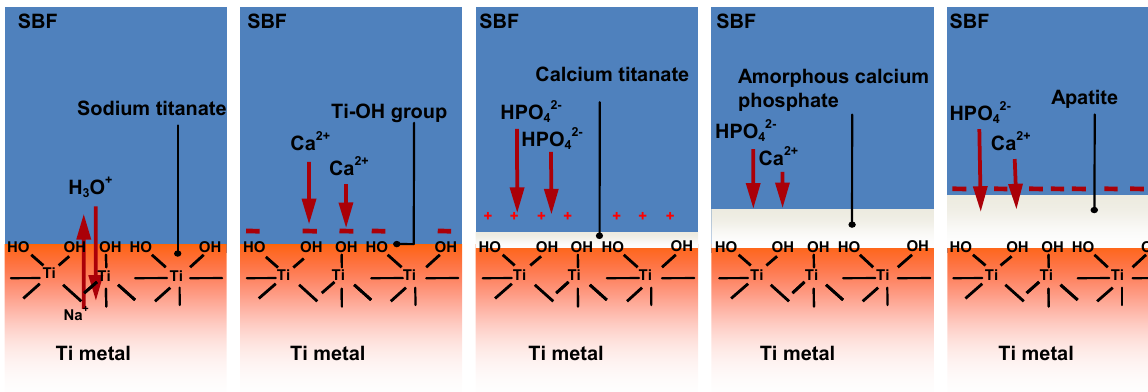
Figure 7. Process of apatite formation on NaOH- and heat-treated Ti metal in SBF.